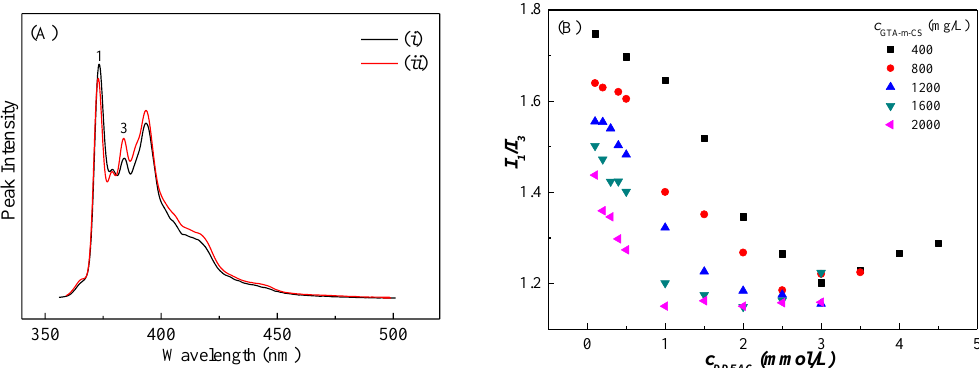
Figure 5. Plots of steady state fluorescence emission spectra ( A ) for GTA-m-CS/DDEAC solutions with DDEAC concentration lower ( i ) and higher than cmc ( ii ), and I 1 / I 3 against DDEAC concentration ( B ) at 25 °C.